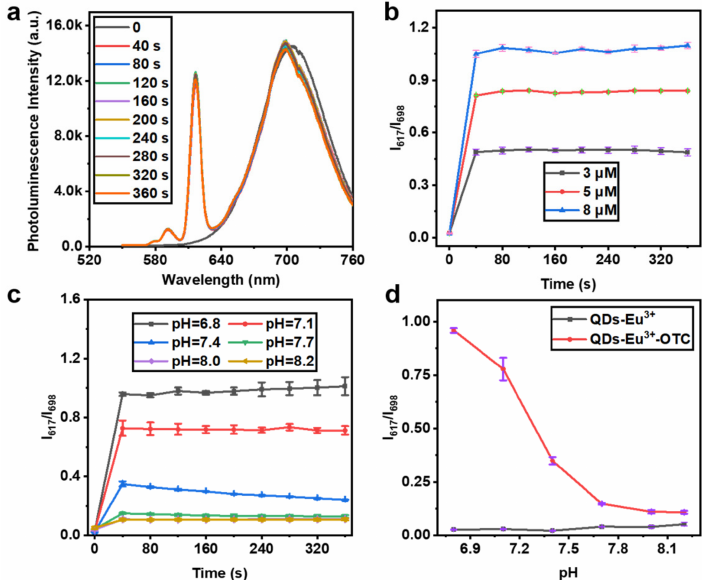
Figure 5. ( a ) Changes in photoluminescence of probe solution in the presence of 5 µ M OTC with reaction time increasing from (0 to 360) s. Point plot of I 617 /I 698 of the probe for OTC detection at various concentrations of OTC (3 µ M, 5 µ M, and 8 µ M) ( b ) and different pH (6.8–8.2) ( c ). ( d ) pH influence on probe response towards 5 µ M OTC.